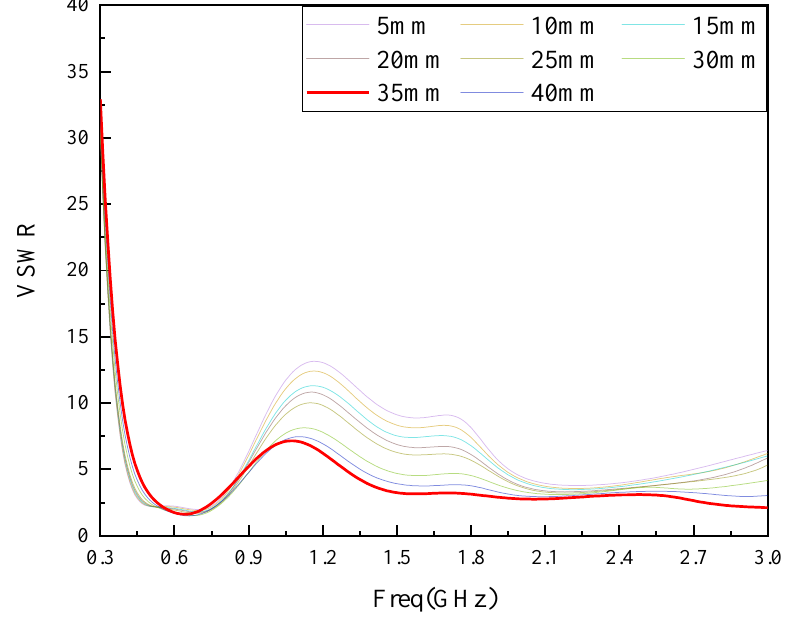
L Figure 2. 3 parameter simulation optimization diagram. L Figure 2. L 3 parameter simulation optimization diagram. Figure 2. 3 parameter simulation optimization diagram.